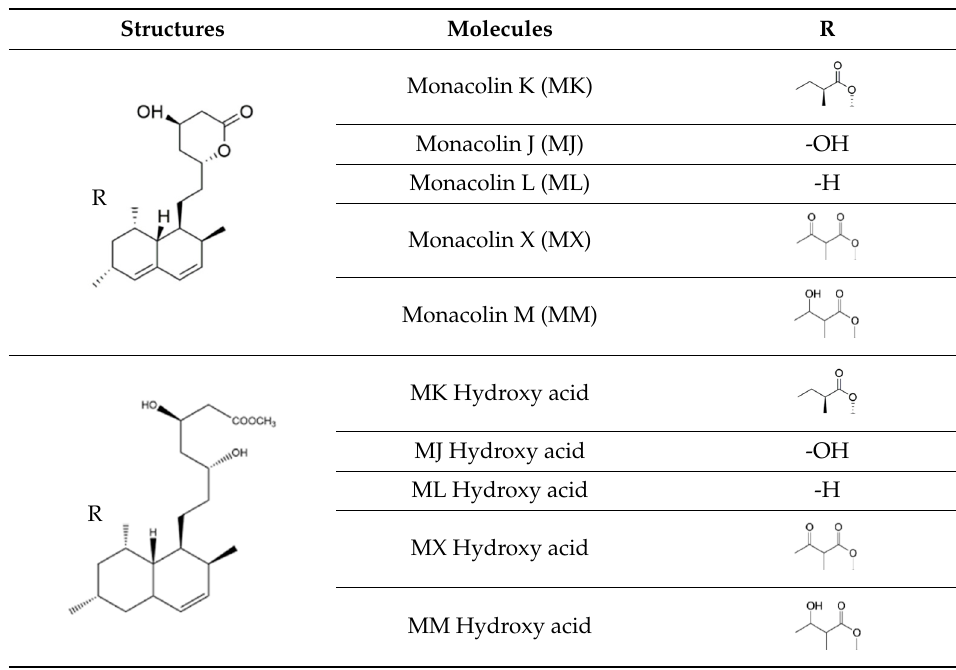
Table 1. Chemical Structures of main monacolins from Red Yeast Rice.